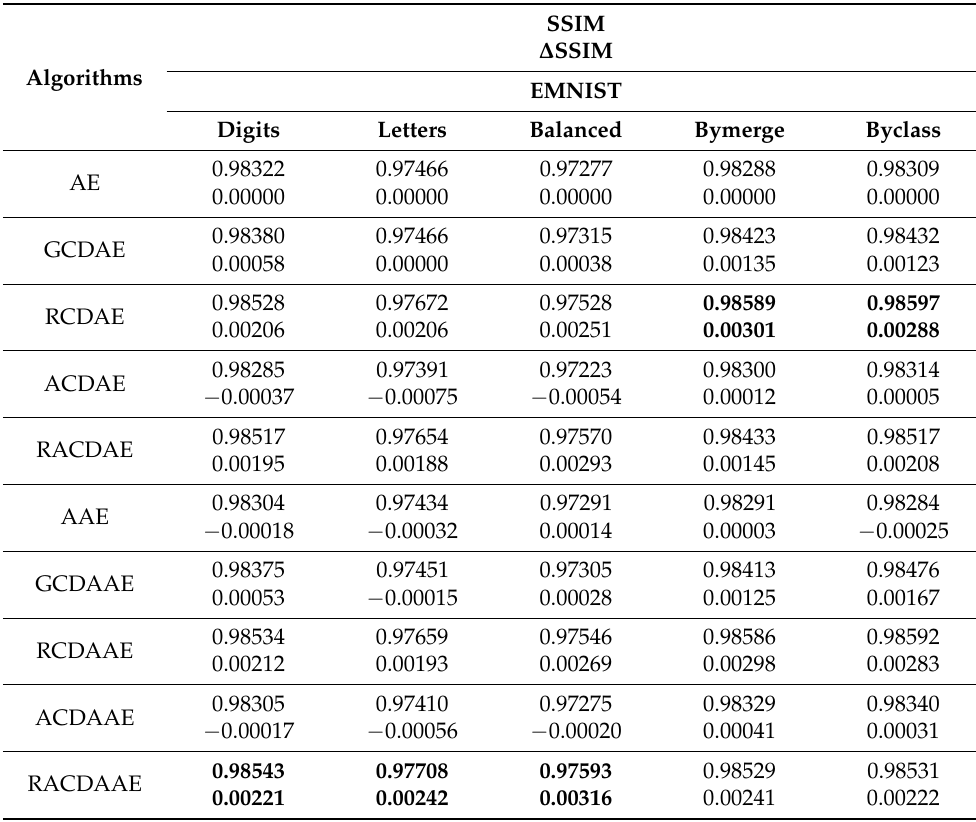
Table 6. Experimental results on the EMNIST data